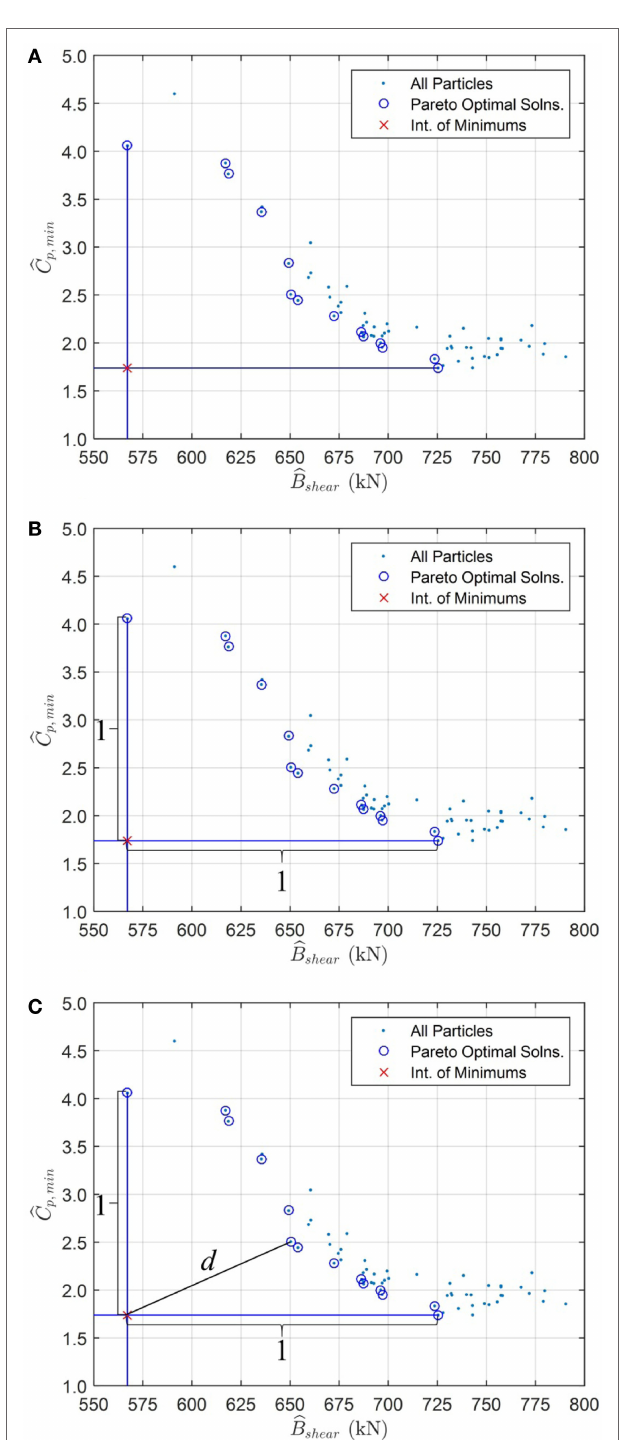
FIGURE 11 | Procedure used for determining particle costs at each iteration. (A) Identify the Pareto front and locate the intersection point of the minimum objective function values. (B) Normalize the distance between the minimum and maximum objective function values. (C) Calculate a particle’s cost as the distance d between the particle and intersection point. Repeat for all particles on the Pareto